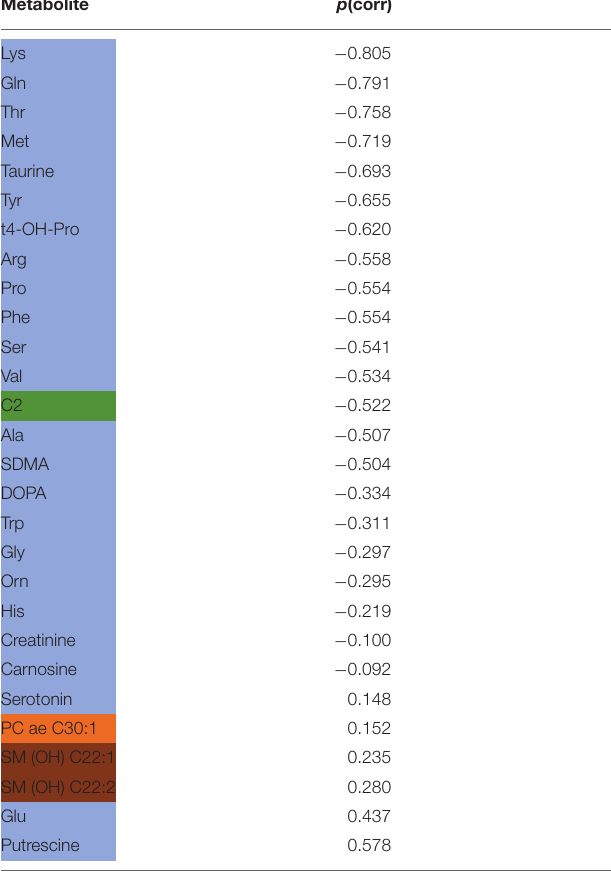
TABLE 2 | OPLS-DA loadings p(corr) values of the measured metabolites in models comparing controls with hyperammonemic